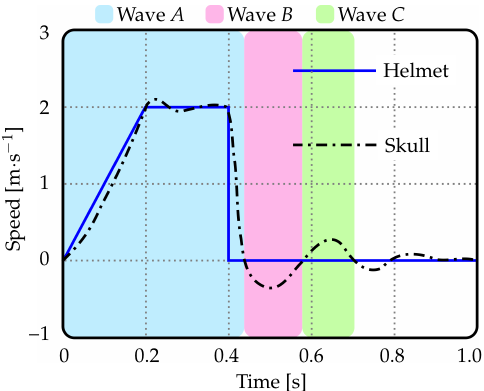
Figure 4. The non-solid padding in a helmet can cause oscillations of the skull when the helmet is subjected to prescribed speed (solid blue line). This is evident from the black dash-dotted line that represents the fluctuating speed of the skull inside the padded